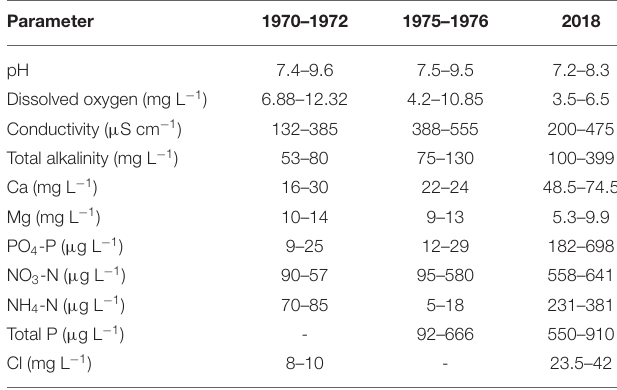
TABLE 1 | Changes in the spatial extent of lakes and wetlands of Srinagar between 1911 and 2004 (Source: Rashid and Naseem, 2008). S. No.